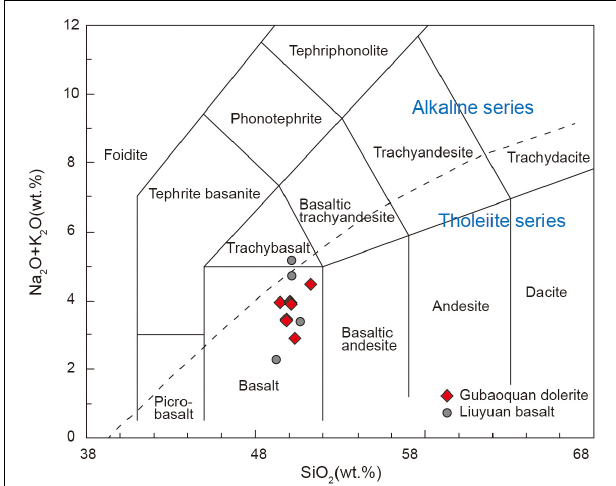
FIGURE 4 | Total alkali–silica (TAS) diagram [after Le Bas et al.